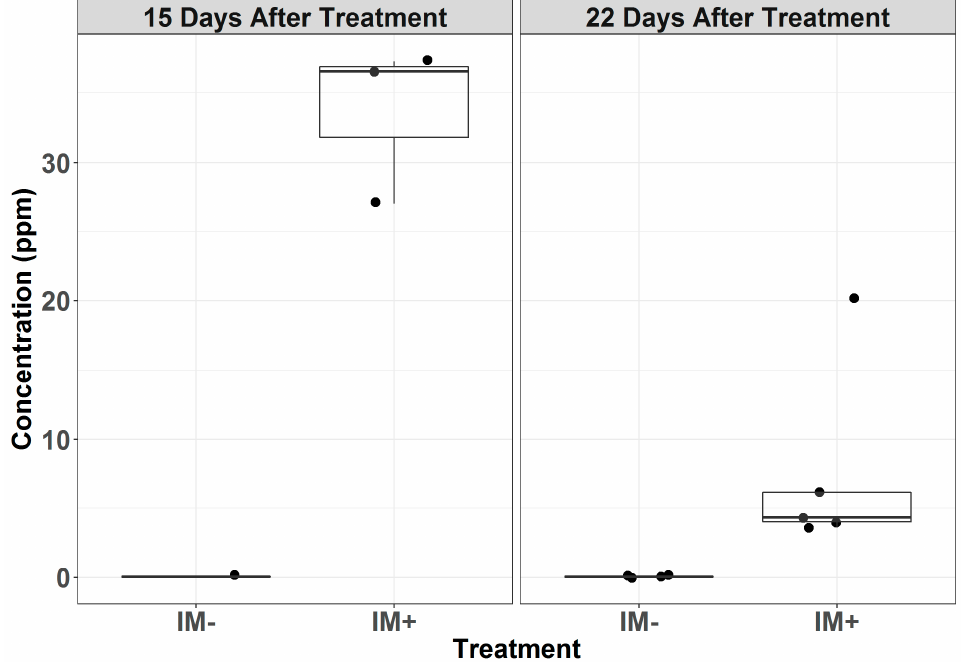
Figure 2. Concentration (ppm) of imidacloprid in powdery mildew conidia collected from treated (IM + ) and untreated (IM − ) plants 15 and 22 days after treatment. Points represent the individual samples, and the overlaying boxplots represent the quantiles.